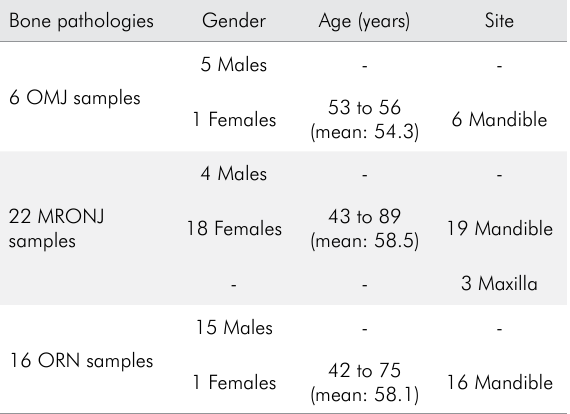
Table 2. Table showing incidence rates by gender, age, and lesion sites.